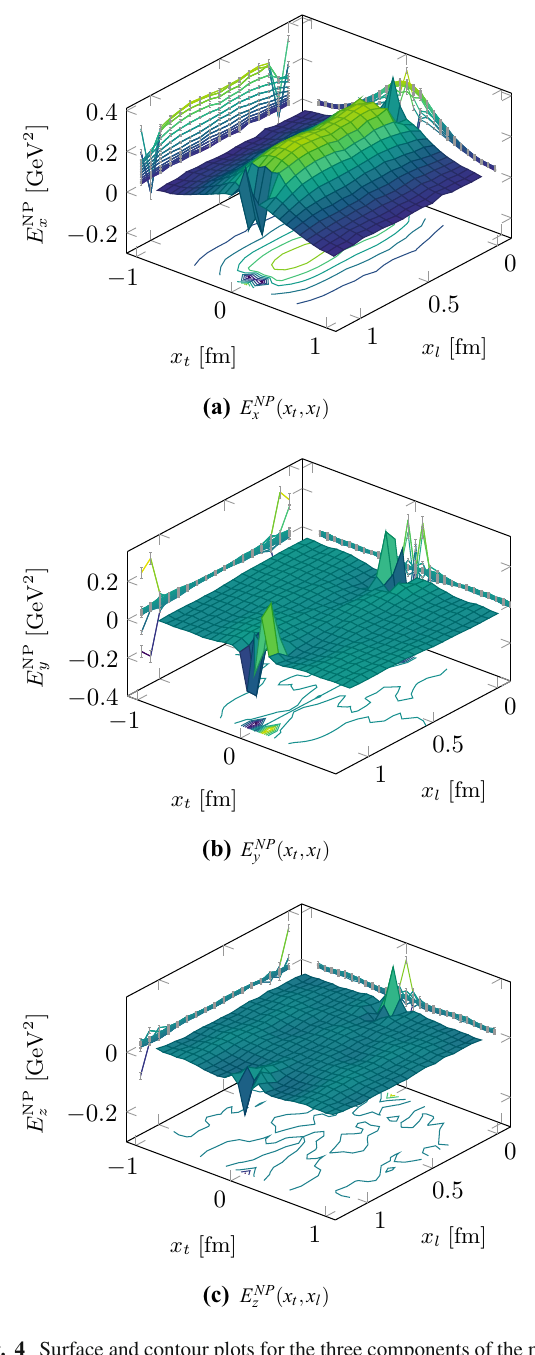
Fig. 4 Surface and contour plots for the three components of the non- perturbative chromoelectric field, E NP ≡ E − E C , at β = 6 . 240 and d = 1 . 142 fm. All plotted quantities are in physical units